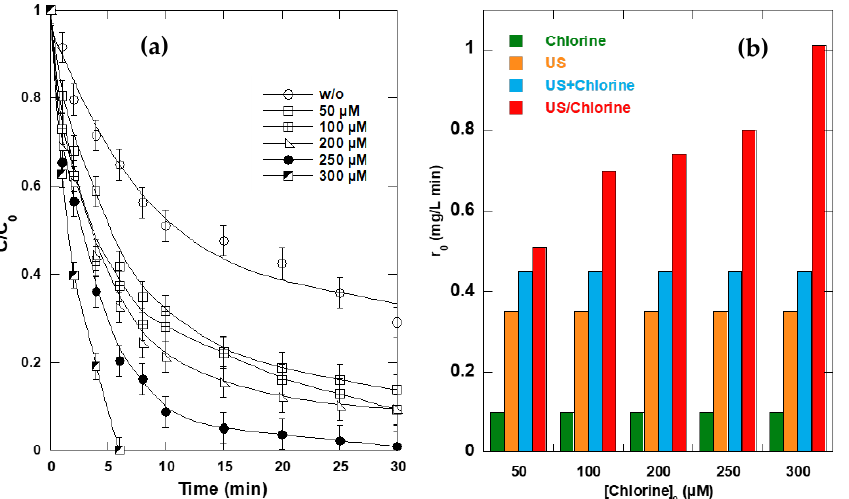
Figure 4. Effect of initial chlorine concentration on the sonochemical degradation of ARAC ( a ) (conditions: C 0 = 5 mg · L − 1 (10 µ M), [chlorine] 0 = 50–300 µ M, V = 150 mL, pH 5.5, temperature: 25 ± 1 °C, frequency: 600 kHz, power: 120 W) and variation in initial ARAC removal rate (r 0 ) with respect to [chlorine] 0 for chlorination alone, US alone and US/chlorine combination ( b ) (the sum of the two processes separately, US + chlorine, was added for comparison with the combined process).